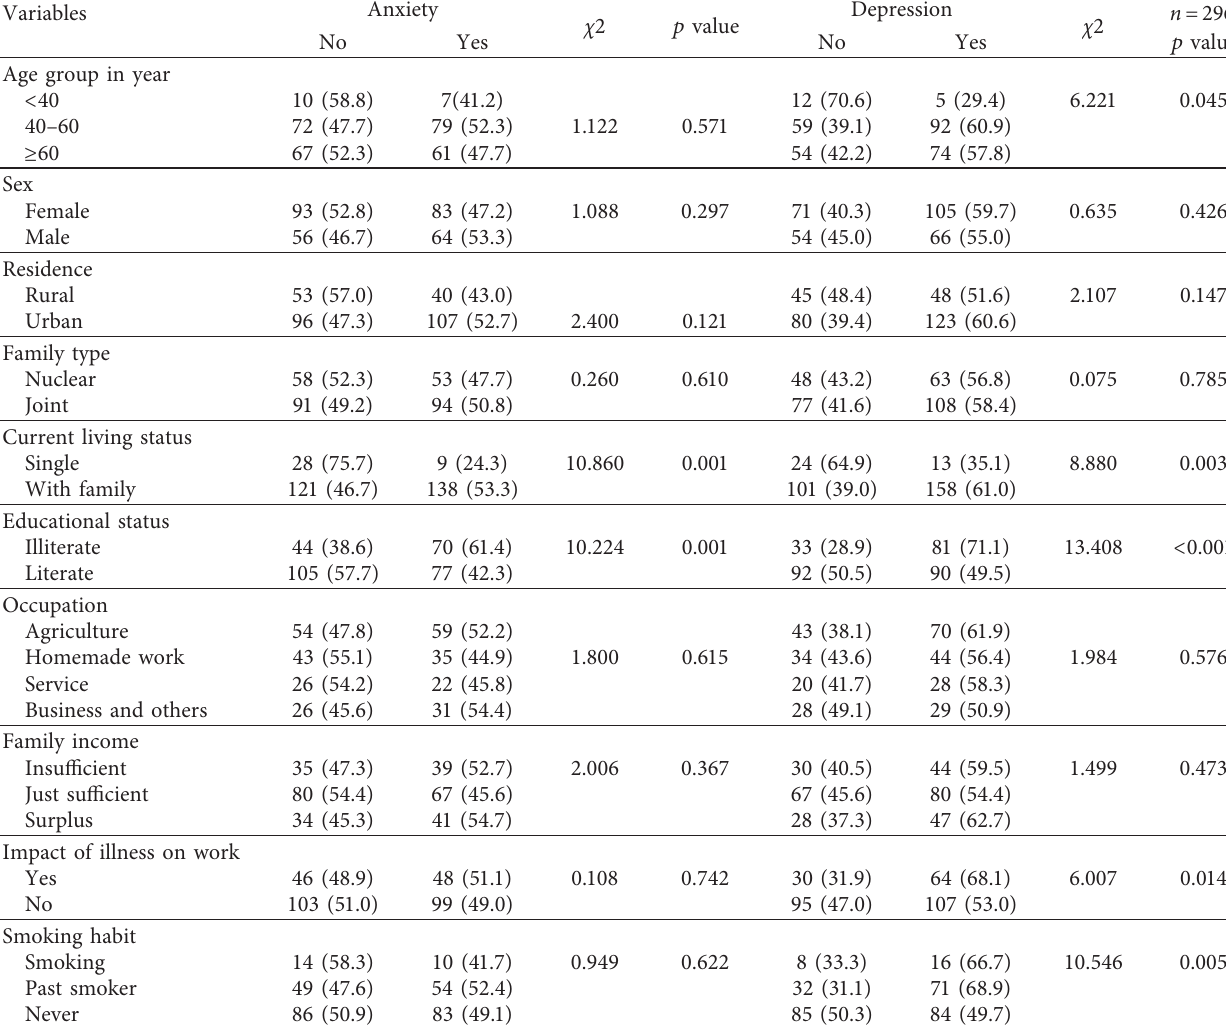
Table 4: Association between anxiety and depression with selected sociodemographic and behavioral pattern of patients.